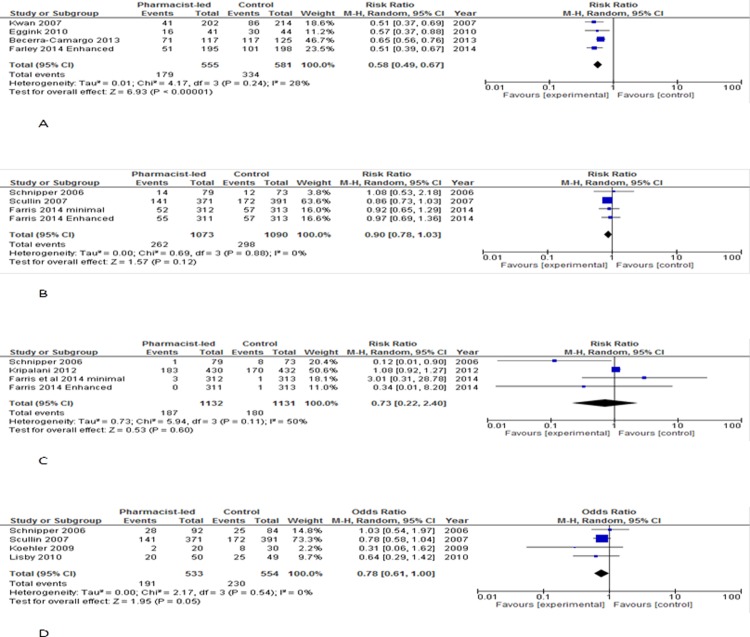
Forest plot comparisons of experimental (intervention) vs. control groups in four studies for medication discrepancy (A) three studies for potential ADEs (B) three studies for preventable ADEs (C) and four studies for healthcare utilization post-hospital discharge (D). Pharmacists-led interventions included medicine reconciliation and tailored patient counselling post hospital discharge. Farley [27] and Farris [28] used two tiers of pharmacist interventions: enhanced and minimal.